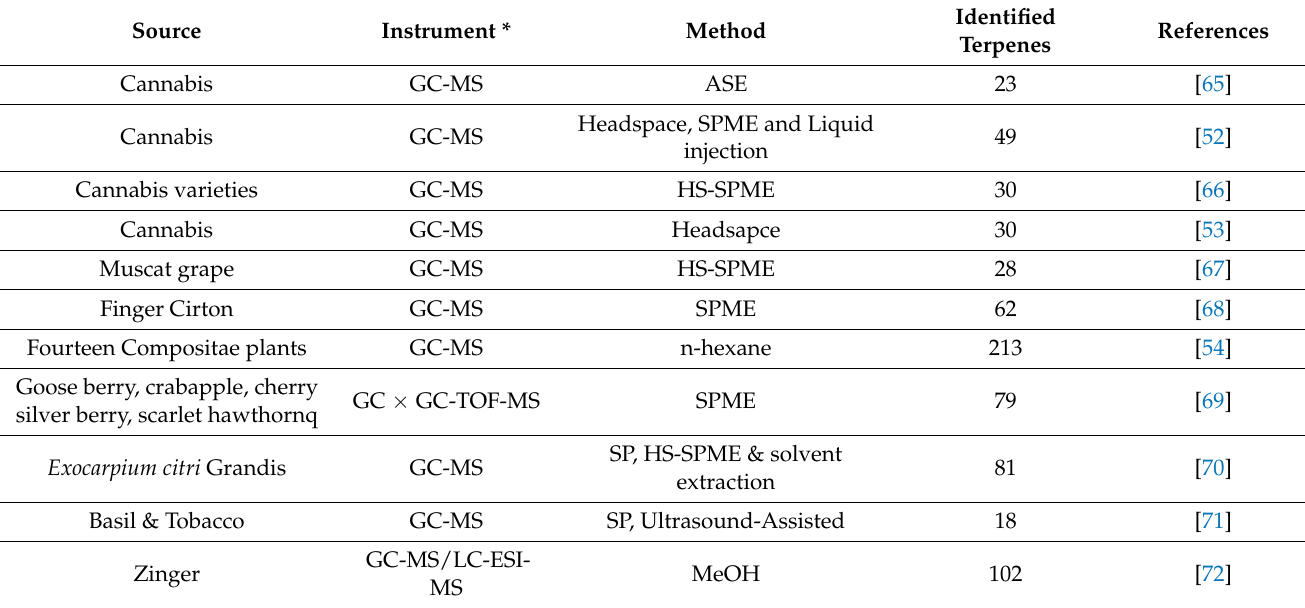
Table 2. Identification of terpenoid metabolite compounds and analytical methods